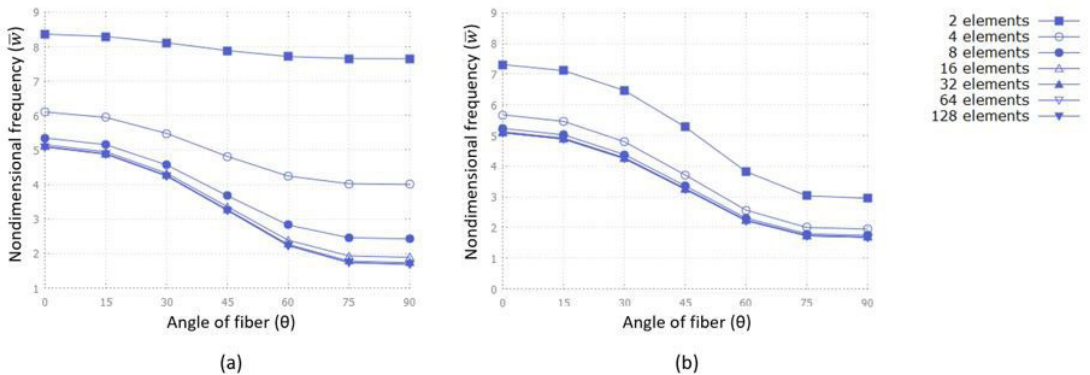
Figure 5. ( a ) Second frequency for different ply fiber directions for the clamped-free (CF) beam computed using the parasitic shear finite element model; ( b ) Second frequency for different ply fiber directions for the clamped-free (CF) beam computed using the corrected finite element